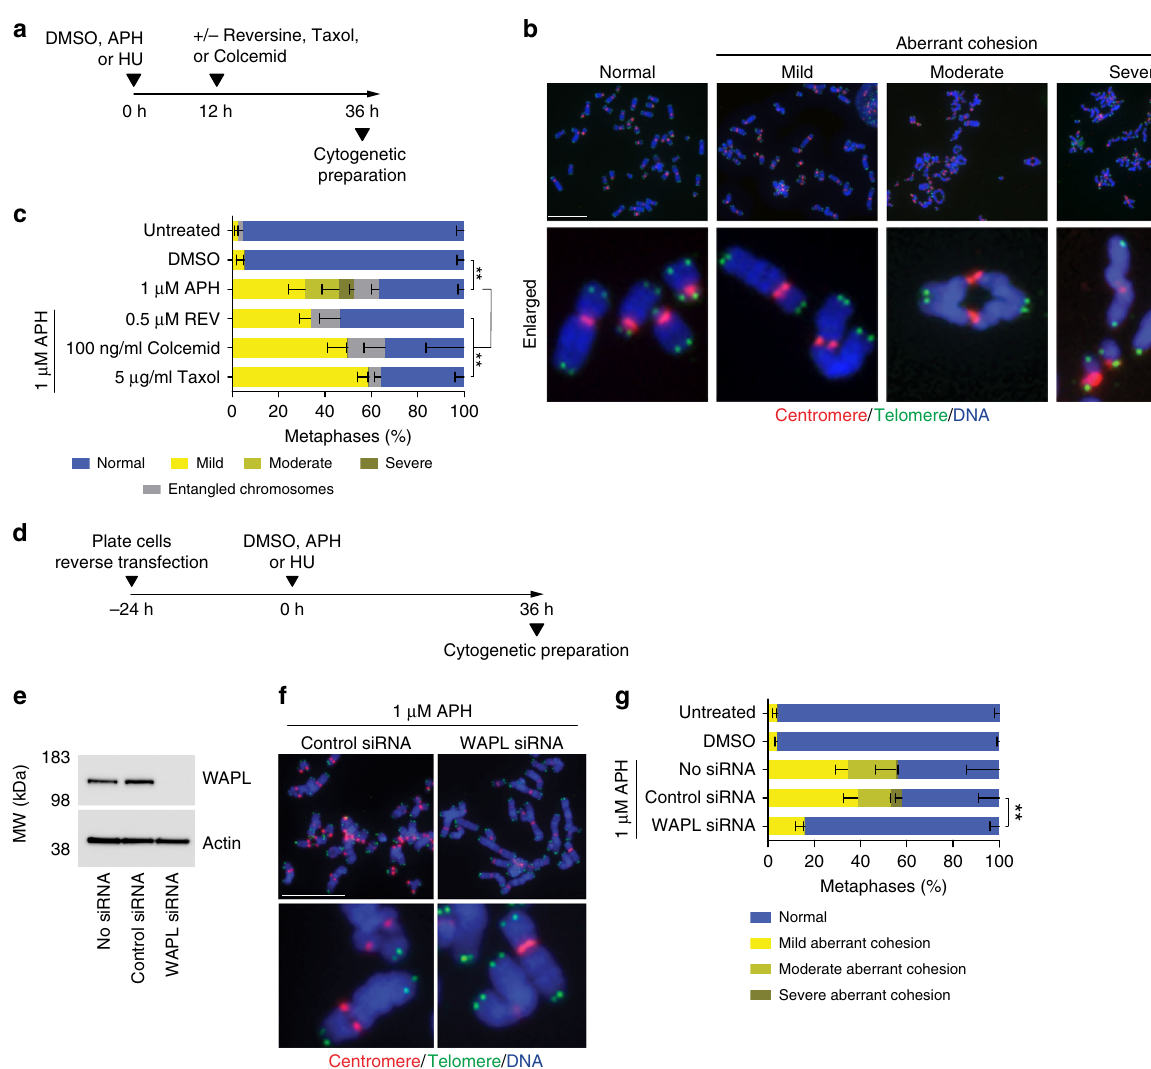
Fig. 4 Replication stress induces WAPL-dependent cohesion fatigue. a Time course for experimentation in ( b , c ). b Representative images of cytogenetic chromosome spreads depicting the replication stress-induced cohesion phenotypes from HT1080 6TG cells stained with DAPI (blue), centromere (red) and telomere (green) FISH. c Quantitation of cohesion phenotypes depicted in ( b ) in HT1080 6TG cells treated with DMSO or APH, ± reversine (REV), colcemid or Taxol (mean ± s.e.m., n = 3 biological replicates scoring ≥ 152 chromosome spreads per condition, Fisher ’ s Exact Test). d Experimental time course for ( e – g ). e Western blots of whole cell extracts from HT1080 6TG cells treated with WAPL or control siRNA. f Representative images of cytogenetic chromosome spreads from HT1080 6TG cells treated with APH and siRNA. g Quantitation of cohesion phenotypes in HT1080 6TG cells treated with APH ± siRNA (mean ± s.e.m., n = 3 biological replicates scoring ≥ 144 chromosome spreads per condition, Fisher ’ s Exact Test). For all